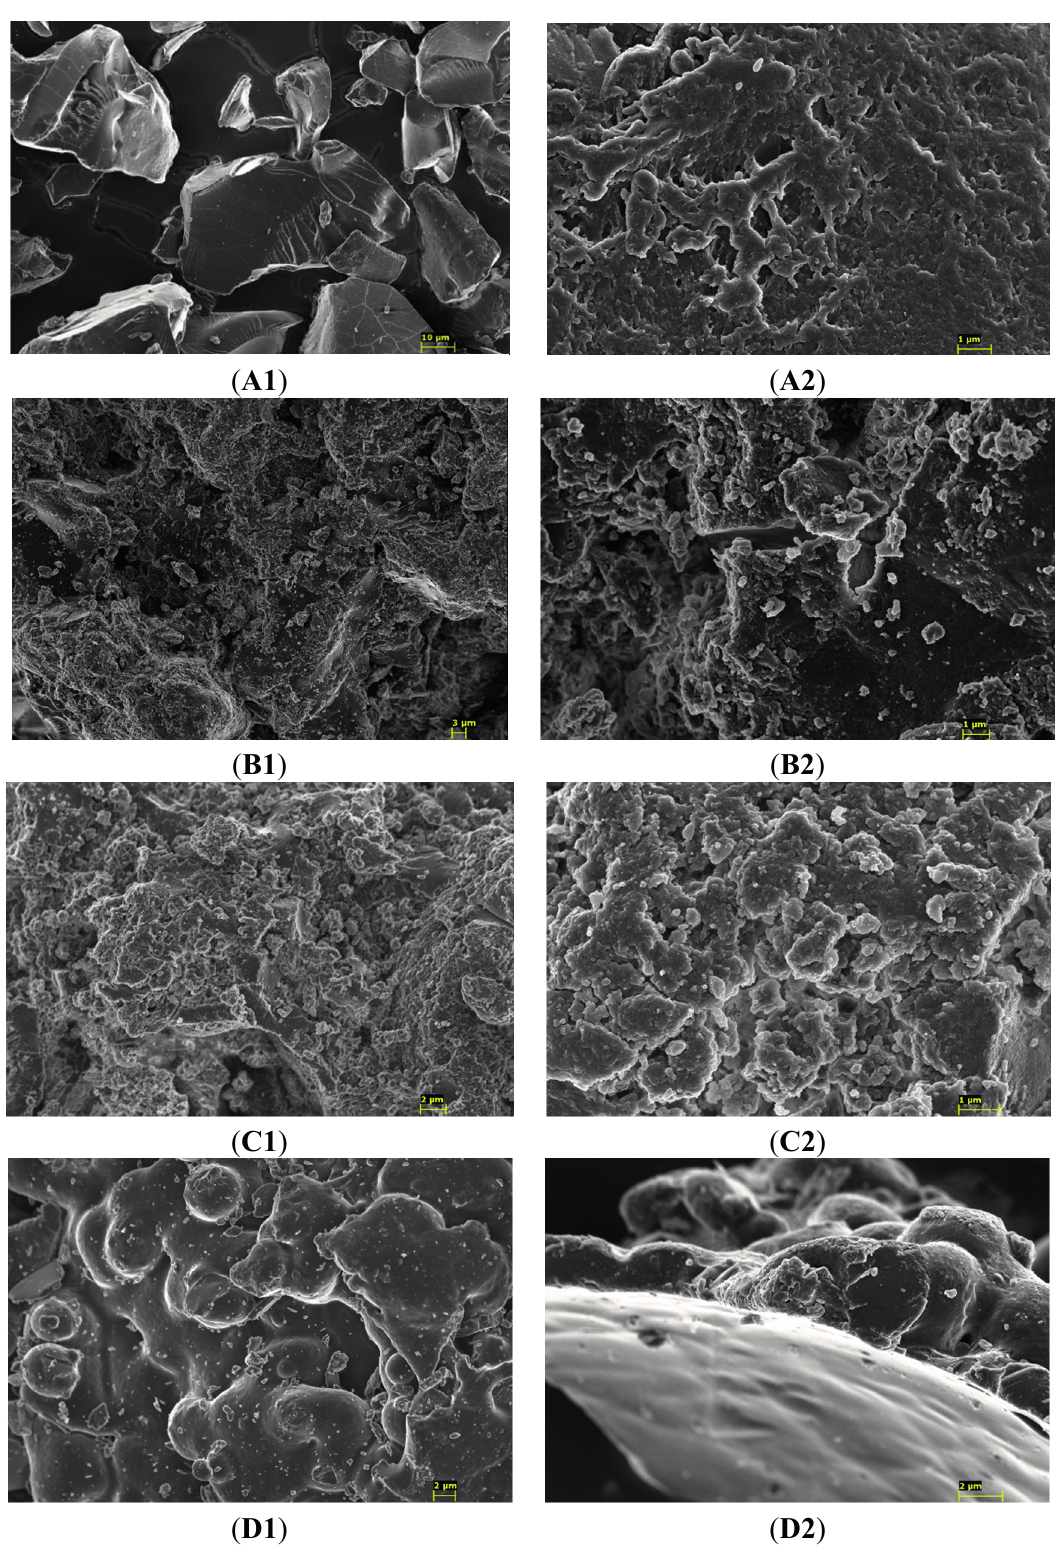
Figure 3. Electron microscopy analysis. Low ( left ) and high ( right ) resolution micrographs of the cationic polymers cholestyramine ( A ), polymer 21 ( B ), and neutral polymers 8 ( C ) and 11 ( D ), being the magnification ×2000 ( A1 ), ×20,000 ( A2 ), ×2500 ( B1 ), ×15,000 ( B2 ), ×7500 ( C1 ), ×24,000 ( C2 ), ×6000 ( D1 ), ×13,000 ( D2